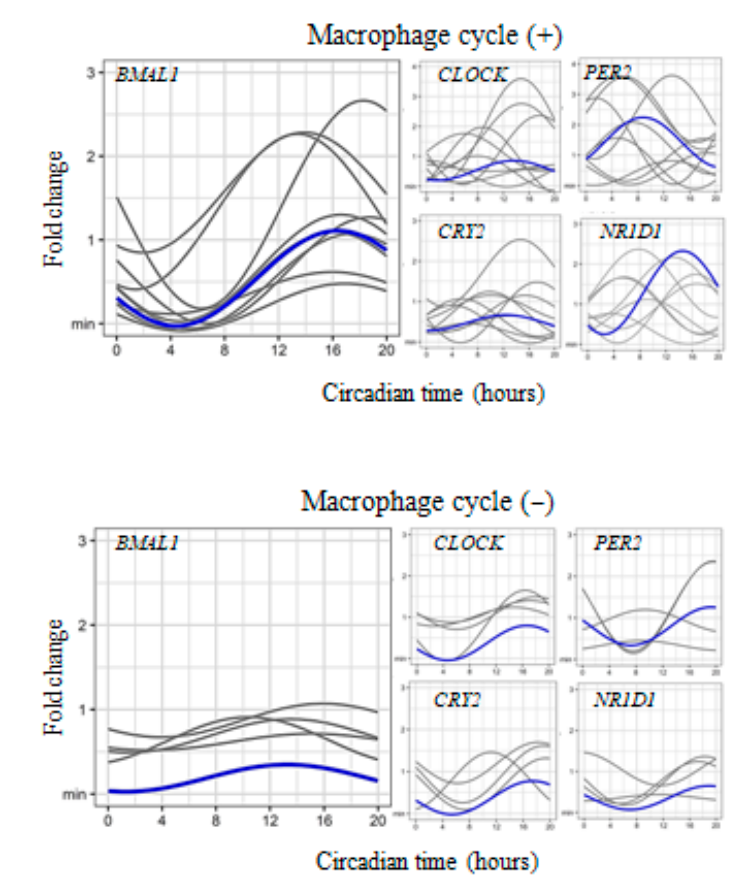
Figure 1. Circadian clock gene expression in placental macrophages. ( A , B ) macrophages (n = 13, including ( A ) n = 9 and ( B ) n = 4 for macrophages with or without cycle respectively) were isolated from placentas from healthy women and the expression of the clock genes (BMAL1, CLOCK, PER2, CRY2, and NR1D1) was evaluated with qRT-PCR every 4 h for 24 h and expressed in fold change from the maximum value. Each sinusoid (in gray) represents the expression of the clock genes over time for each donor after adjustment of the values by the cosinor model (mean of 3 technical replicates for each donor). The mean of the fold change of biological replicates was represented in blue. The statistical analysis was performed using the cosinor function using R studio (v3.4.0, Boston, MA, USA). Table 1. Rhythmic parameters (mesor, amplitude and acrophase) for placental macrophages. A p value < 0.05 for mesor, amplitude, and acrophase implies a rhythmicity of the investigated gene.